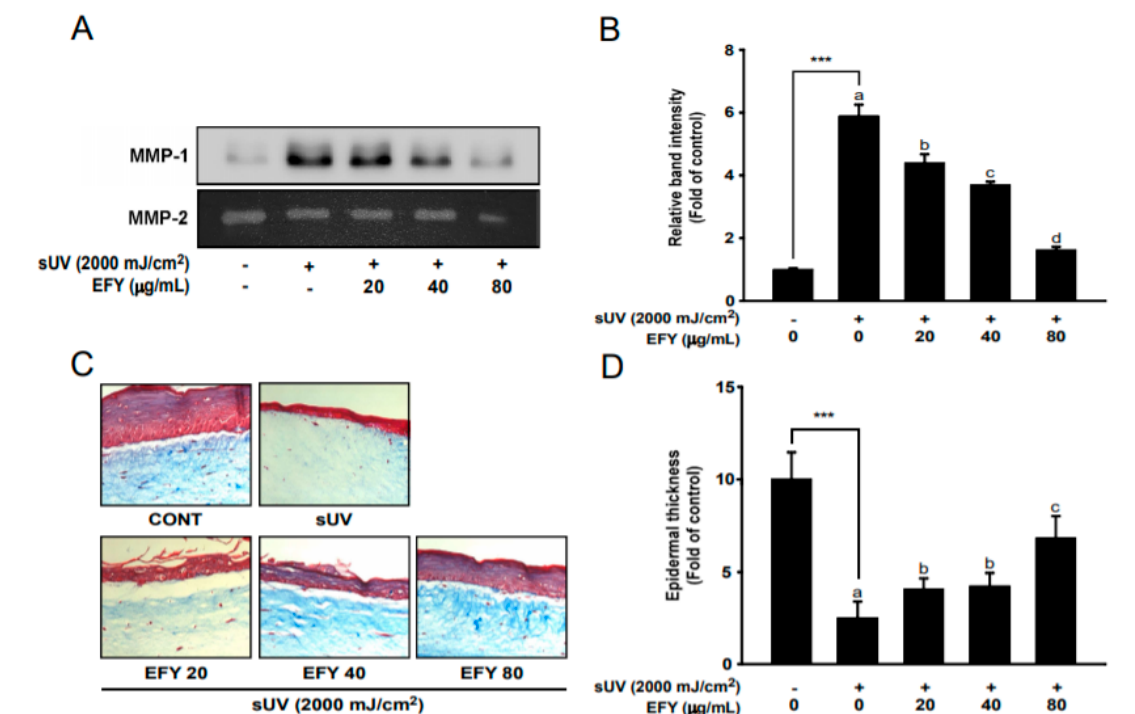
Figure 5. EFY attenuates sUV-induced MMP-1 secretion and skin damage in a three-dimensional (3D) skin culture model. ( A , B ) Inhibitory effects of EFY on MMP-1 protein secretion in 3D artificial skin. MMP-2 expression was used for the normalization of MMP-1. Data ( n = 3) are mean values ± SD. ( C ). Masson’s trichrome staining to visualize collagen fiber and epidermal thickness. ( D ) Quantification of epidermal thickness. Data ( n = 5) are mean values ± SDs. *** significant difference ( p < 0.001) between the control and sUV-exposed control. Mean values with different letters indicate statistically significant differences among sUV-exposed groups ( p < 0.05). Representative western blots from three independent experiments are shown ( n = 3).